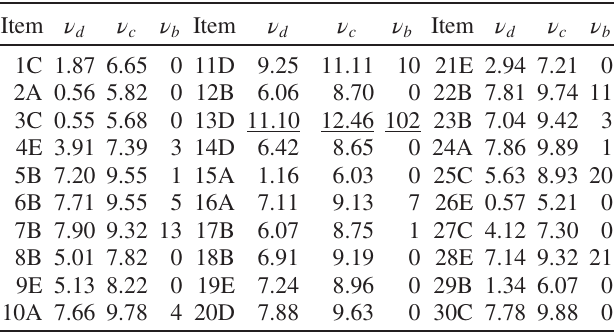
TABLE V. Degree, closeness, and betweenness centrality measures for all thirty correct items. The values of ν multiplied by a constant factor of 10 3